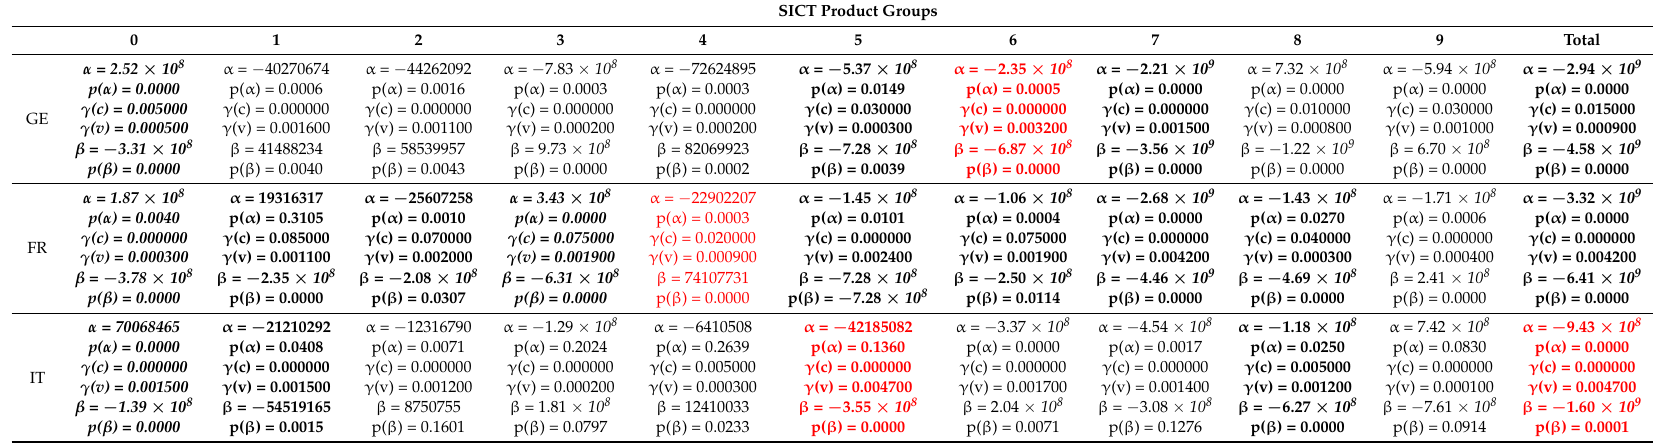
Table A2. Hysteresis with a variable play area (EPUI,